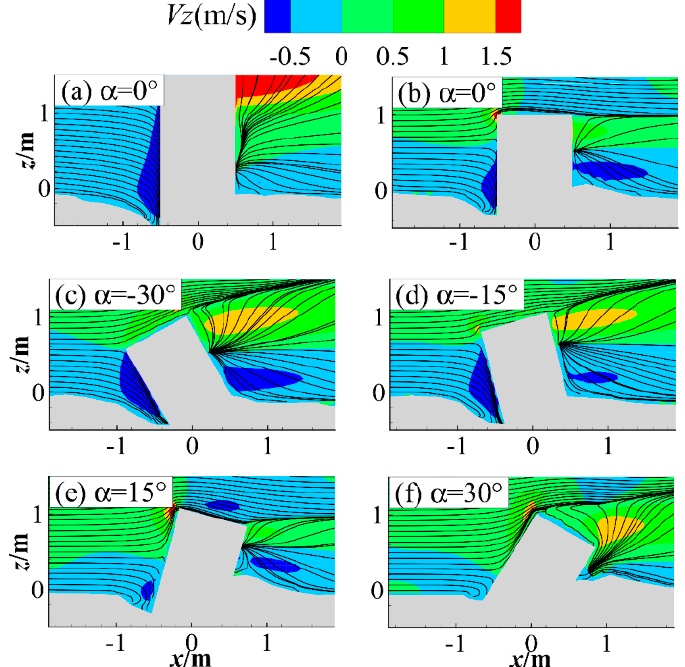
Figure 9. Streamlines and the contour of Vz in symmetry plane at t = 320 s, ( a – f ) represents Case 1 to Case 6 in Table 2, respectively.